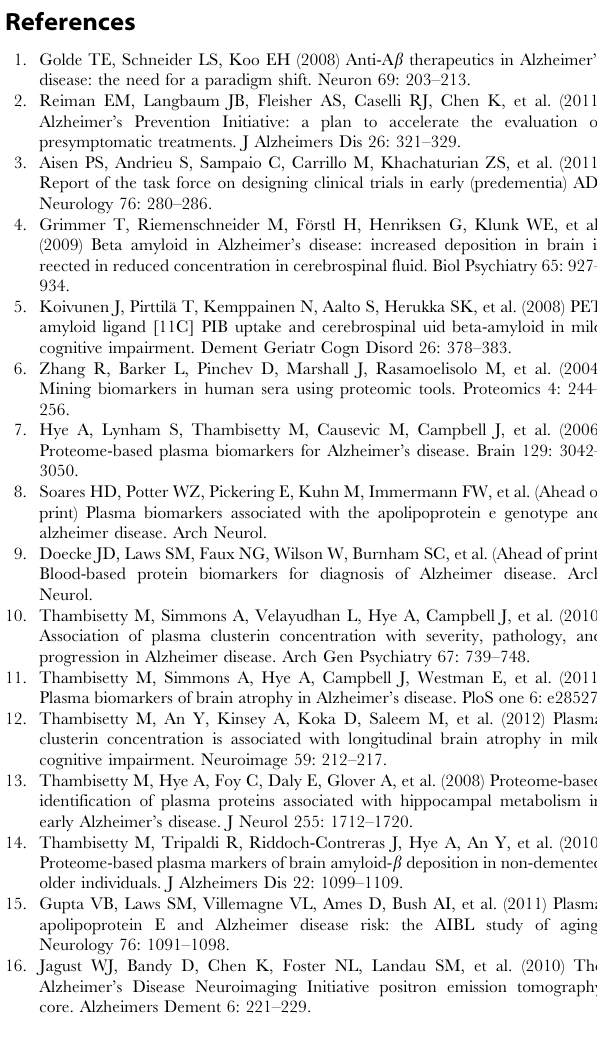
Figure S1 Distribution of brain amyloid burden. A stacked histogram showing the distribution of brain amyloid burden for different diagnostic groups. Control (dark blue), MCI (green) and AD (red) represent subjects who remained in these diagnostic groups throughout follow up period. Control/MCI (light blue) and MCI/AD (orange) represents subjects whose diagnosis converted between these groups during the follow up period. Brain amyloid burden is in relative units. Table S1 Characteristics of the ADNI-PiB PET cohort by diagnostic group. P-values were calculated when appropri- ate for differences across diagnostic groups, using a Kruskal-Wallis x 2 test for continuous characteristics and simulated contingency table p-values for discrete characteristics. (PDF) Table S2 Characteristics of the ADNI-RBM cohort by diagnostic group. P-values were calculated when appropriate for differences across diagnostic groups, using a Kruskal-Wallis x 2 test for continuous characteristics and simulated contingency table p-values for discrete characteristics.